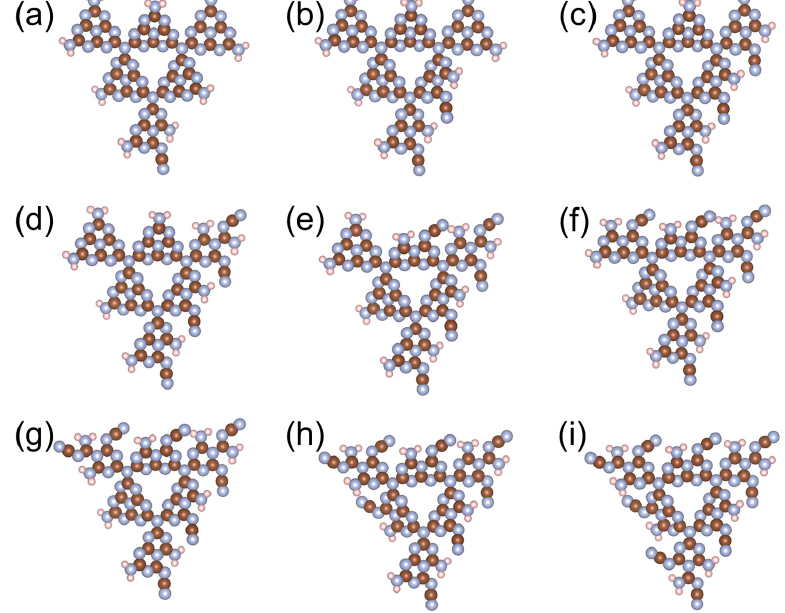
Figure 3. Structures of g-C 3 N 4 -6 with varying numbers of C ≡ N groups. Brown, blue, and pink spheres represent C, N, and H, respectively.